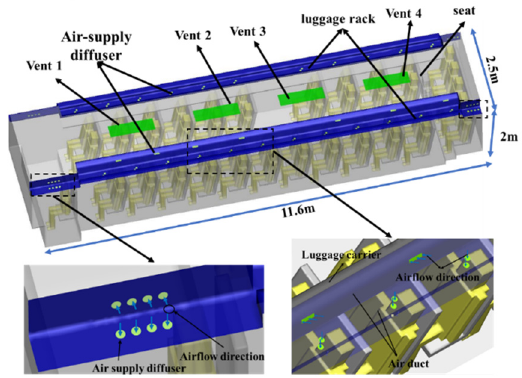
Figure 2. Schematic structure in the